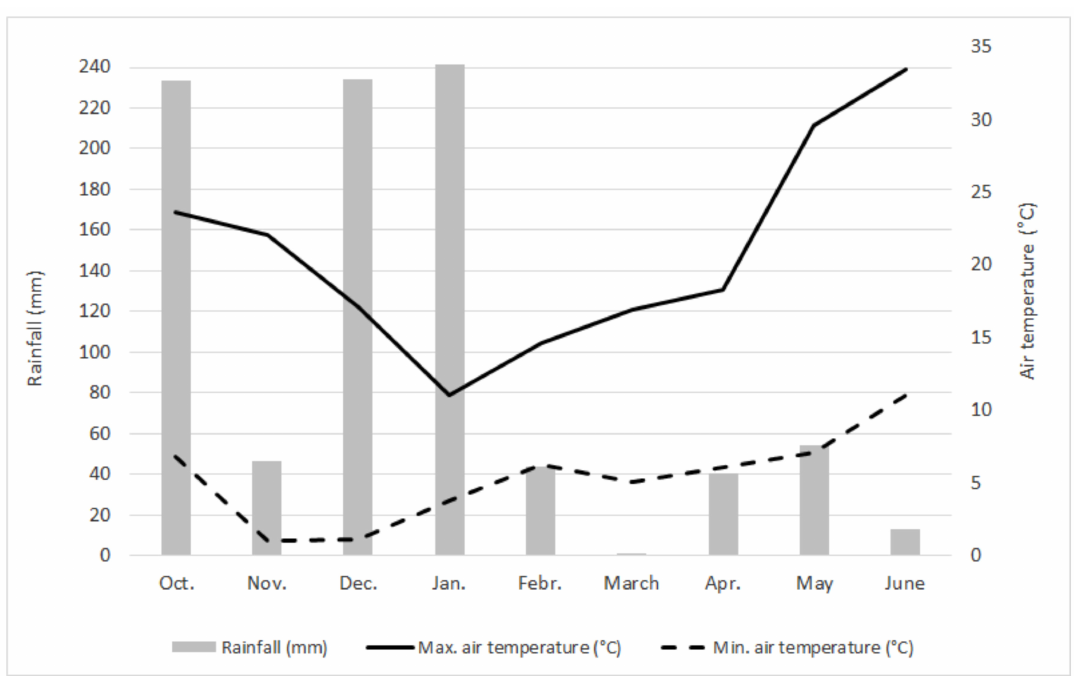
Figure 1. Monthly mean maximum and minimum air temperatures and monthly rainfall of the study period (October 2020–June 2021) at the experimental station of the Centre for Research on Turfgrass for Environment and Sports (CeRTES), Department of Agriculture, Food and Environment, University of Pisa, located at S. Piero a Grado, Pisa, Italy (43 ◦ 40 (cid:48) N, 10 ◦ 18 (cid:48) E, 6 m asl).